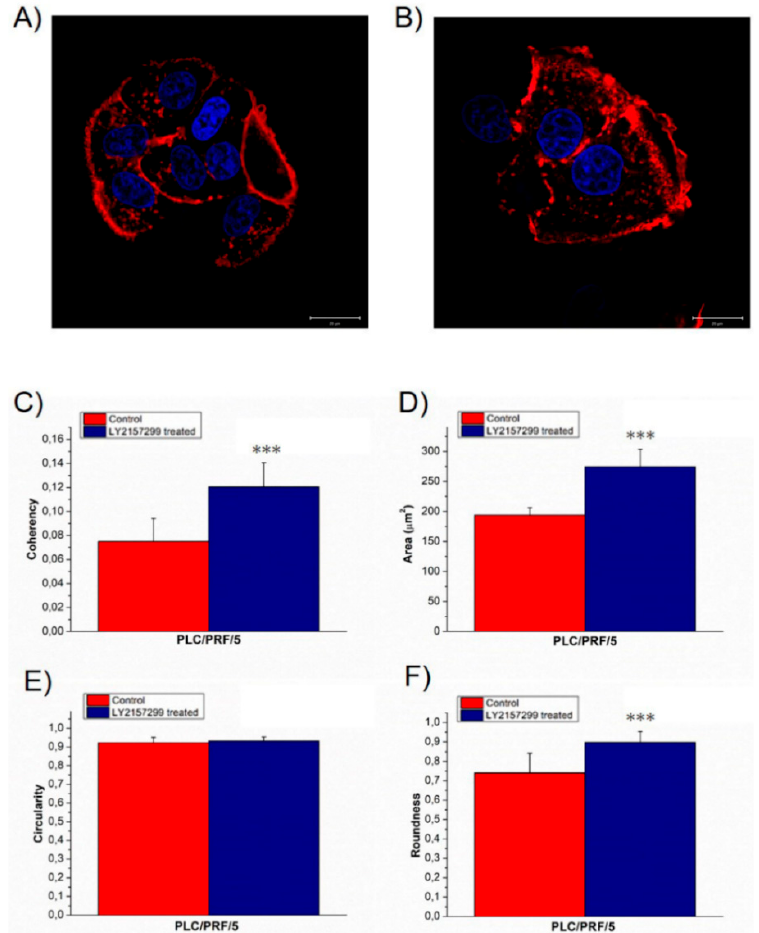
Figure 3. Representative confocal images of PLC/PRF/5 CTR ( A ) and TGF- β treated for 48 h, PLC/PRF/5 TGF- β 1 ( B ); the scale bar in the figures correspond to 20 µm. In the panel the value of F-actin coherency ( C ), nuclear area ( D ), circularity ( E ) and roundness ( F ) were reported. The analysis of F-actin and nuclear morphology of control and TGF- β 1 treated PLC/PRF/5 cells, by using ImageJ software. Results were statistically significant for p < 0.005 (indicated as ***).